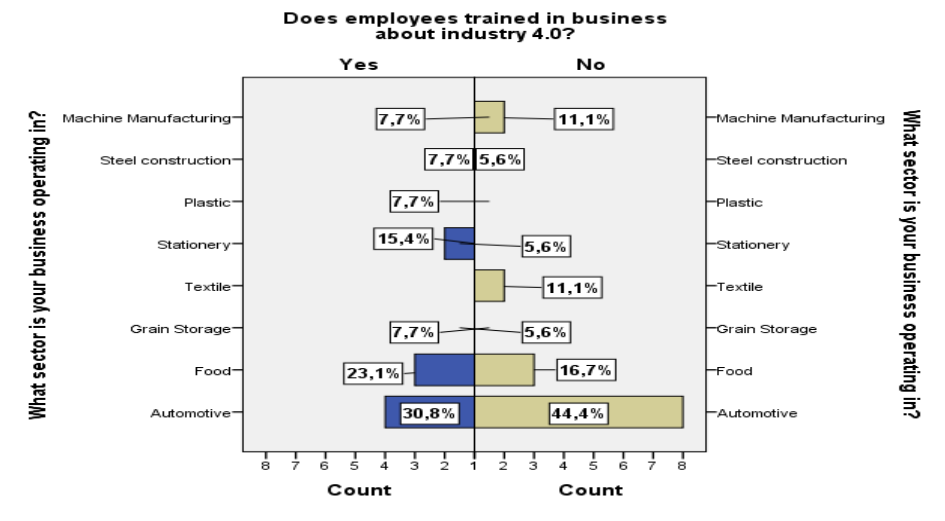
Fig. 5. Sectoral distribution of employees' training in industry 4.0.